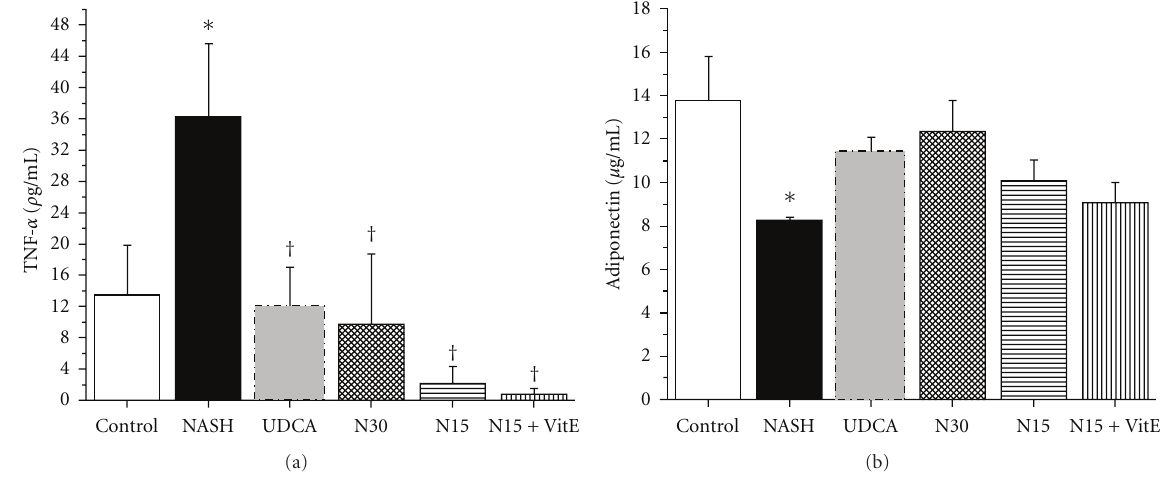
Figure 3: E ff ect of treatments on inflammatory cytokines and adipokines. Table 3: Liver histology scoring for macrovesicular steatosis and inflammatory cells